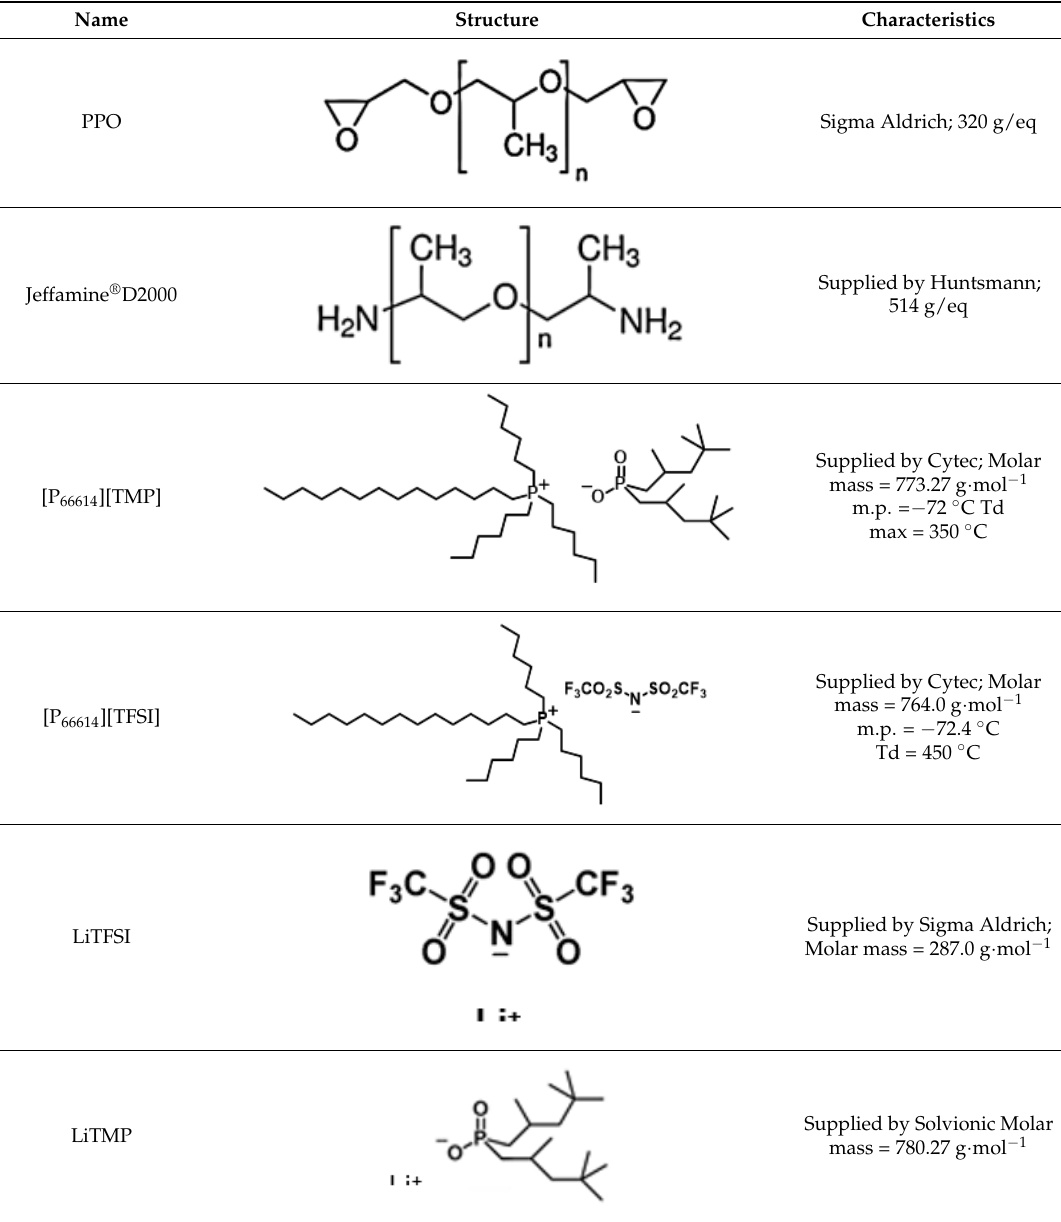
Table 1. Chemical structures and characteristics of the main compounds.